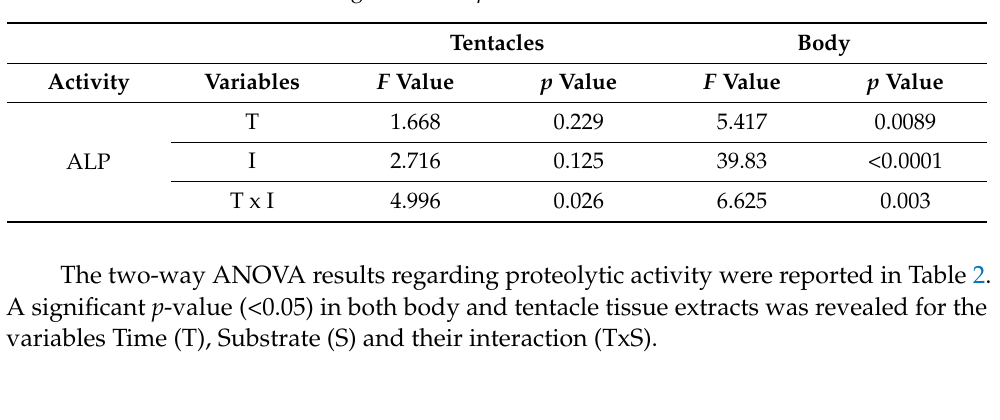
Figure 2. Alkaline phosphatase activity (ALP) and proteolytic activity in tentacles and in the body extracts of A. viridis . ALP in tentacles ( a ) and in the body ( b ) extracts of A. viridis of injured (amputated) and control samples. Kinetics of ALP was expressed as U*mg − 1 of protein. Densitometric analysis of the proteolytic activity based on the integrated value of density (IDV) calculated on SDS-PAGE carried out with gelatin and fibrinogen as substrates using the tentacles ( c ) and the body tissue extracts of amputated specimens ( d ). Data were statistically analyzed using analysis of variance to determine differences between groups and showed mean ± standard error. The letters indicate statistically significant differences between control and its respective treated group. * Indicates differences between groups at each time. Significant differences were detected by Tukey post hoc test—* p < 0.05, ** p < 0.01, *** p < 0.001, **** p < 0.0001. Table 1. Two-way ANOVA analysis results of alkaline phosphatase activity (ALP) measured in the tentacles and body extracts of A. viridis . Statistically significant effects of the following variables—Time (T) and Injury (I) and interactions (TxI). The analyses were carried out using the GraphPad Prism Version 8.0.0. for Windows (www.graphpad.com (accessed on 1 March 2021)). Differences between means were considered significant for p < 0.05.